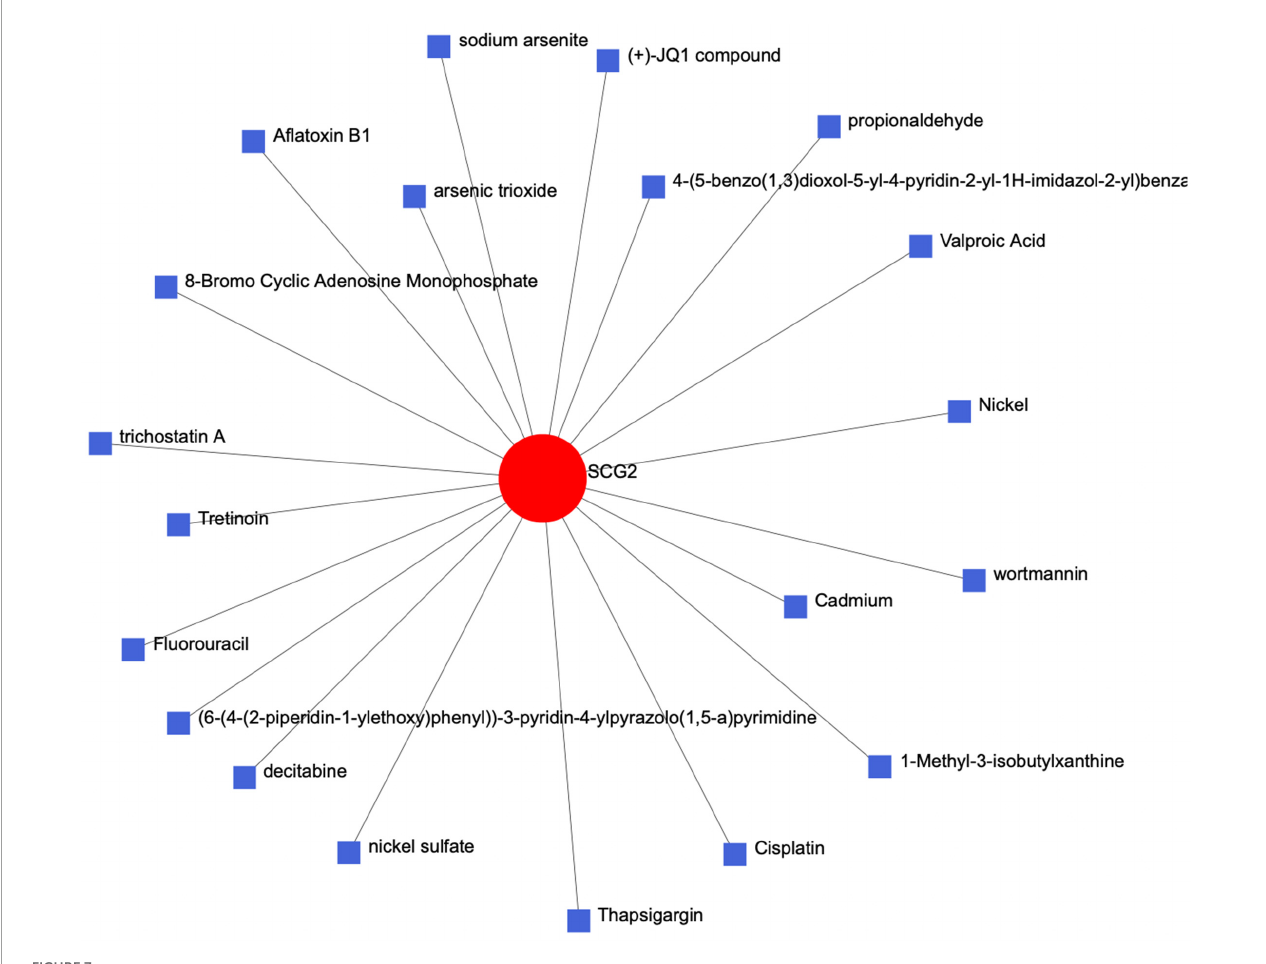
FIGURE7 The protein-chemical-molecular interaction network diagram of the key protein gene SCG2.